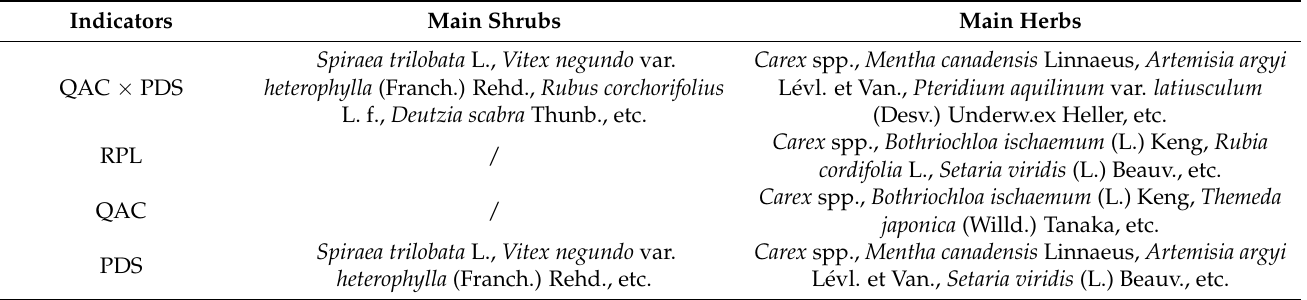
Table 2. Species composition of shrubs and herbs under forest in the study